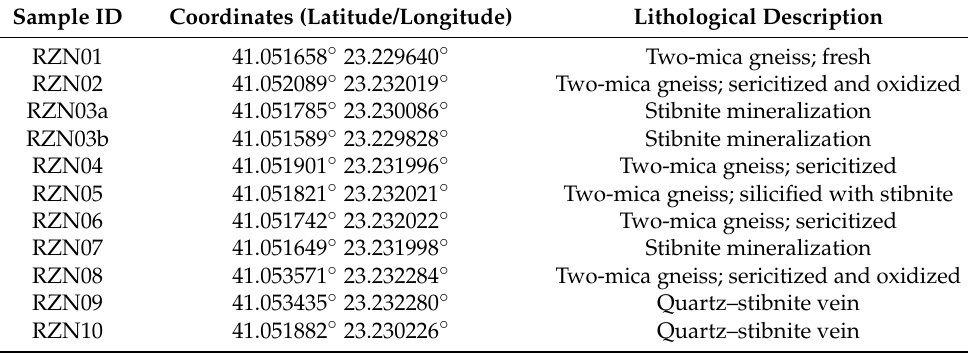
Figure 5. Satellite imagery of the sampling area at “Tas-Kapou”. The sampling points are shown, and the location of the main old galleries is highlighted in yellow. Table 1. Sample identification numbers, localities (coordinates) and lithological descriptions.